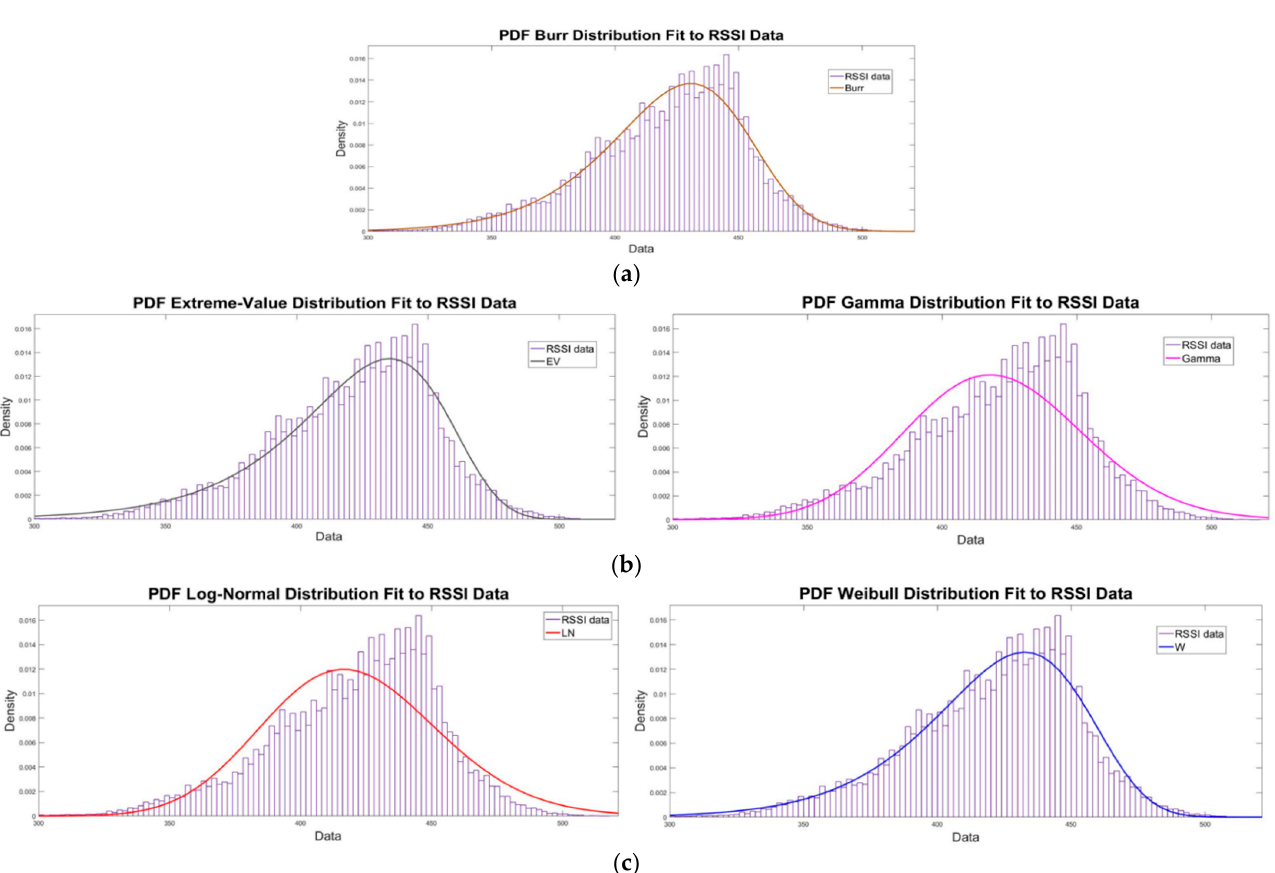
Figure 3. Probability density functions fits to RSSI data for ( a ) Burr distribution, ( b ) Extreme-Value (left) and Gamma (right) distribution, ( c ) Log-Normal (left) and Weibull (right) distribution.